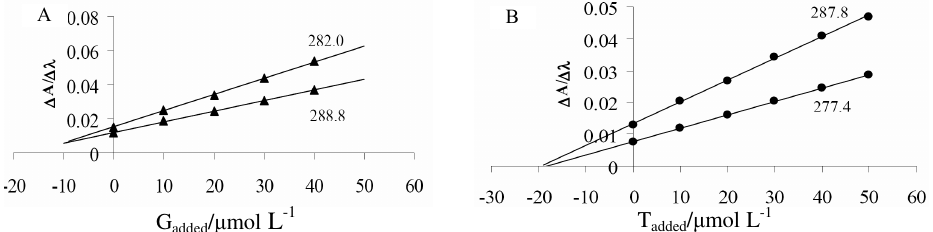
Figure 3. First derivative spectra of (A) 10 µmol L -1 guaifenesin and (B) 10 µmol L -1 theophylline against blank at pH=10.0. The dashed lines are selected wavelengths.